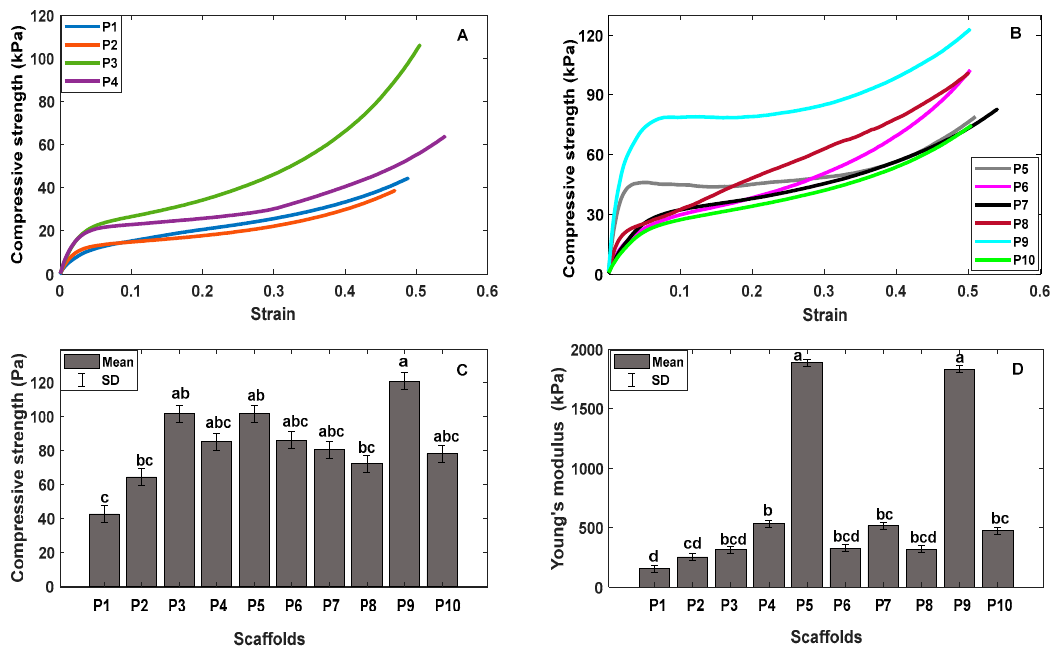
Figure 11. ( A ) Compressive strength-strain curve for ternary blend scaffolds. ( B ) Compressive strength-strain curve for controls scaffolds. ( C ) Compressive strength of scaffolds. ( D ) Compressive modulus of scaffolds. The data are presented as mean ± SD; the different letters indicate significant compressive strength and compressive modulus differences ( p < 0.05).